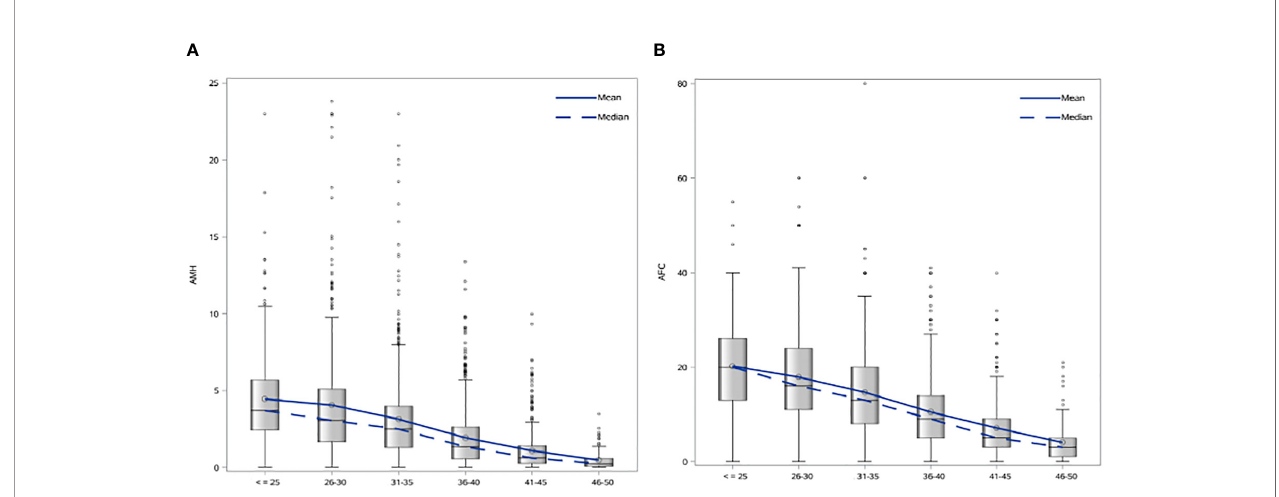
FIGURE 3 | (A) Age-speci fi c AMH mean and median values in 5-year intervals. (B) Age-speci fi c AFC mean and median values in 5-year intervals.